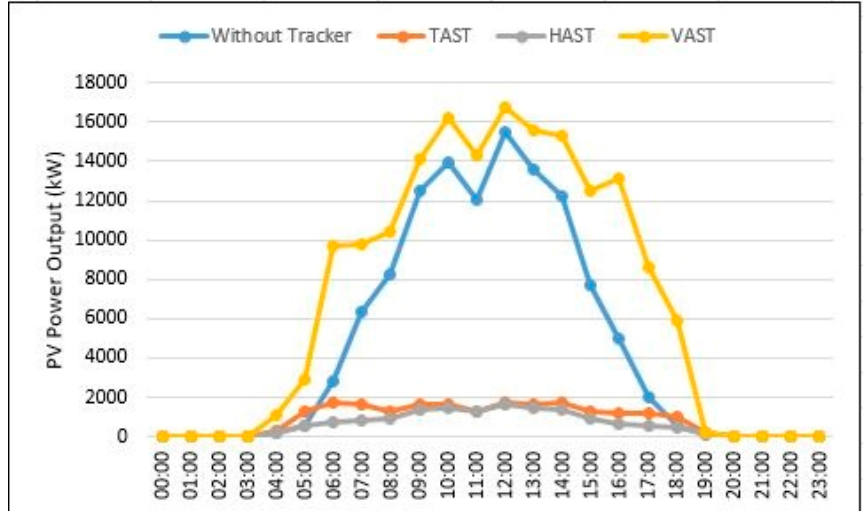
Figure 9. Daily electricity generation graph by PV with different trackers .